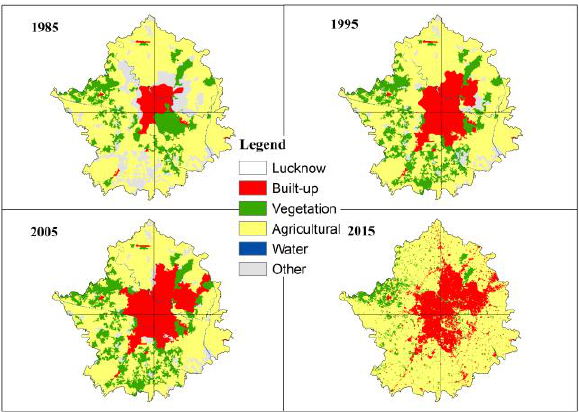
Figure 3. Classified maps of study area in different